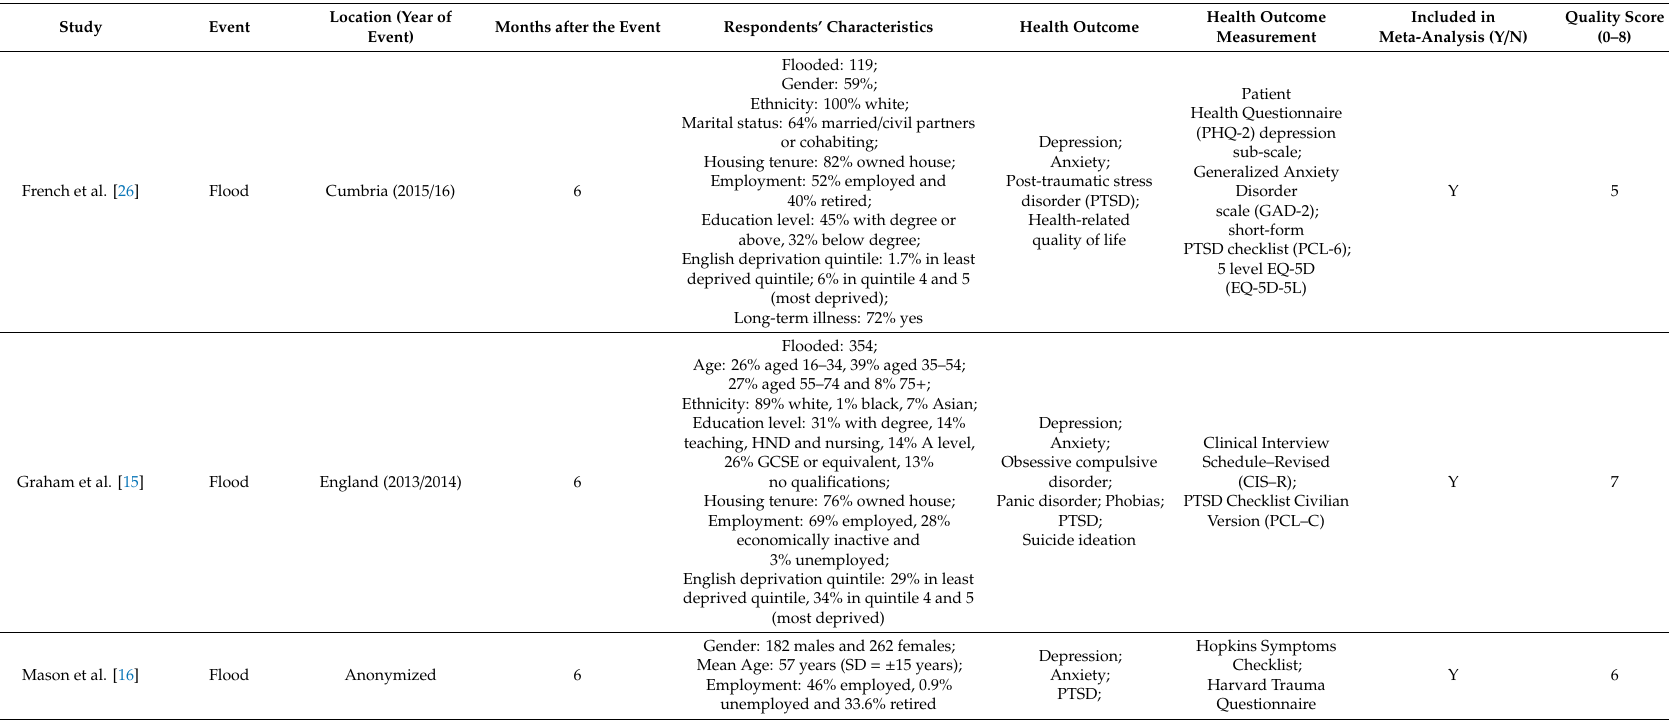
Table 1. Characteristics of the studies included in the narrative review and meta-analysis of the impact of floods and heat waves in mental health outcomes and